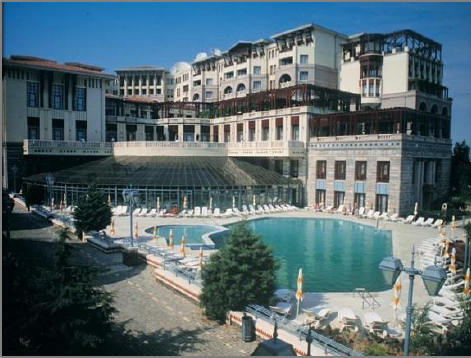
Figure 14 Şefik Birkiye, Klassis Hotel (URL-6)